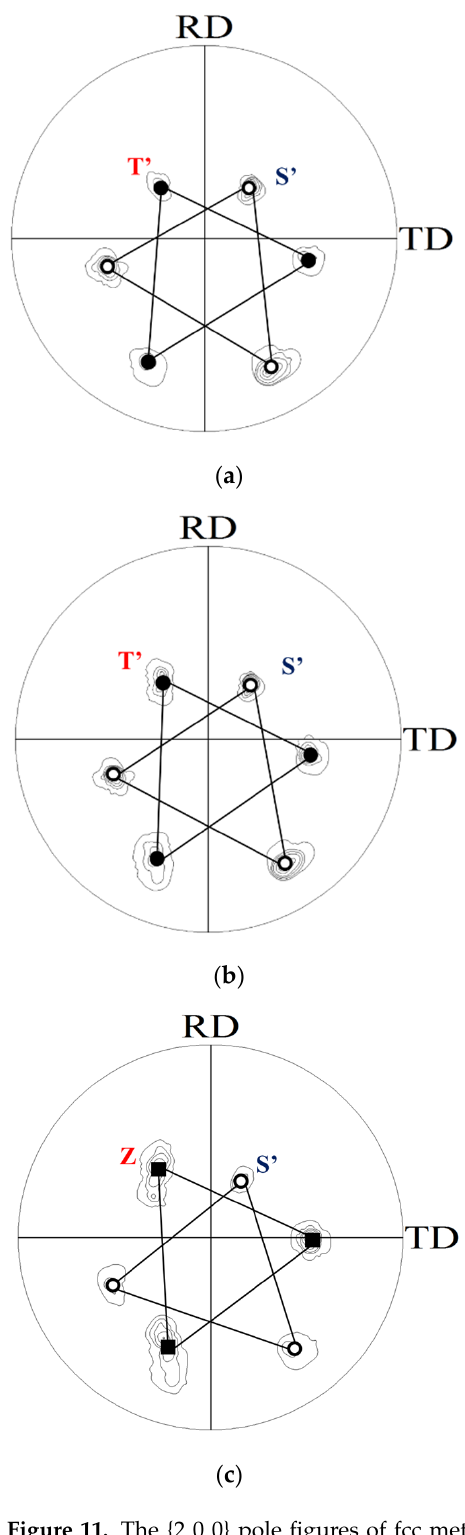
Figure 11. The {2 0 0} pole figures of fcc metal simulated using MTCS-model with single S’ ori- entation after the reduction ratios of ( a ) 30%, ( b ) 60%, and ( c ) 90%. positions on {2 0 0} pole figure of the orientation close to S’ ( 1 2 3 ) (cid:2) (cid:3) Z ( 1 1 1 ) 1 0 1 ,